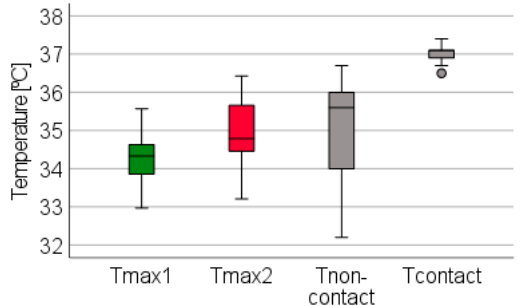
Figure 7. Box plots representation of the maximum temperatures measured with IR cameras and thermometers (HR SP values of 40%, 60% and 80%).